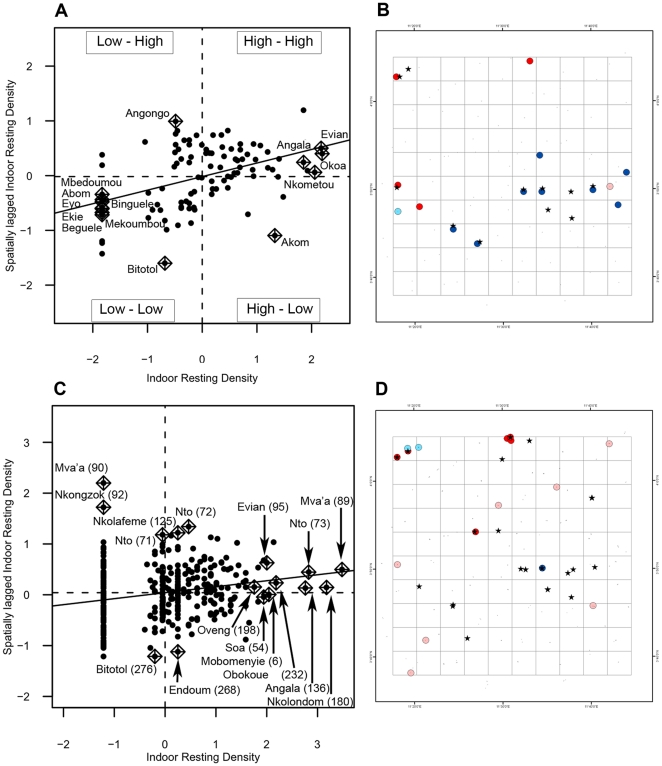
LISA results for An. gambiae.(A) and (C) are Moran scatter plots at the locality and at the house level, respectively. The name of the locality and the house number (in brackets) with large contributions to autocorrelation are displayed. (B) and (D) depict the locations of significant local Moran's I statistics and the type of spatial association between neighboring locations in sampling units with large contributions to the global autocorrelation. (A): locality level and (B): house level. ∧ significant (p<0.01); bright red: High-High; light red: High-Low; deep blue: Low-Low; light blue: Low-High.